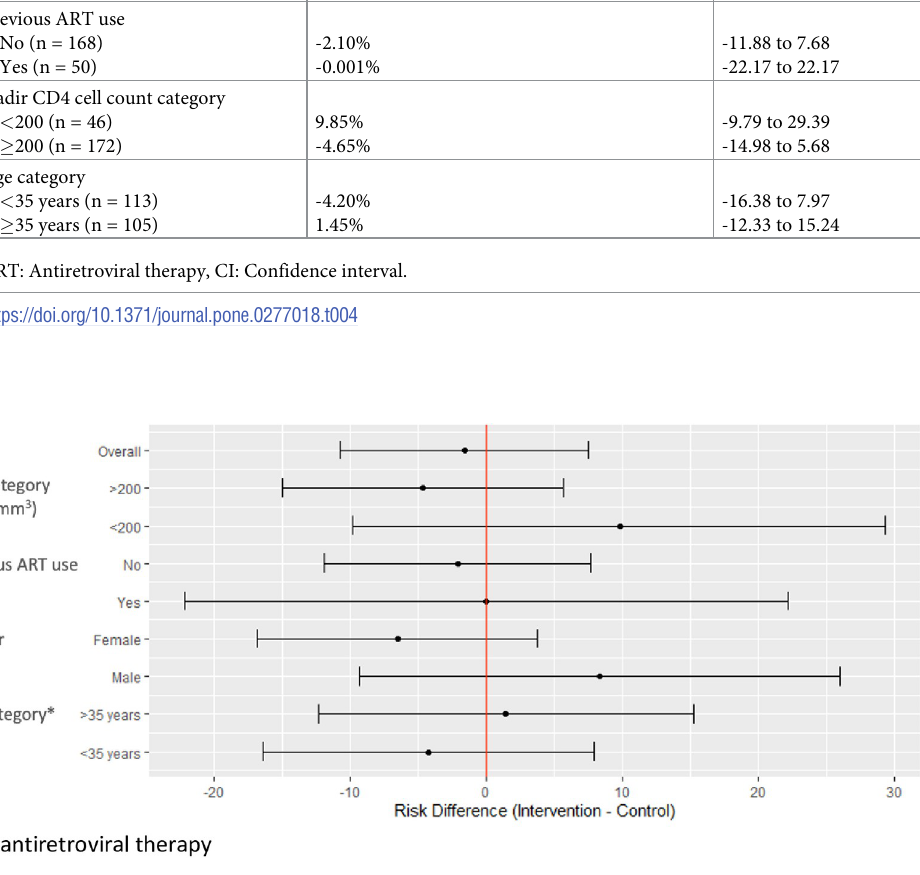
Fig 2. Forest plot of primary outcome (VL < 400 copies/mL at 12 months on ART) across a priori subgroups of demographic and clinical characteristics.